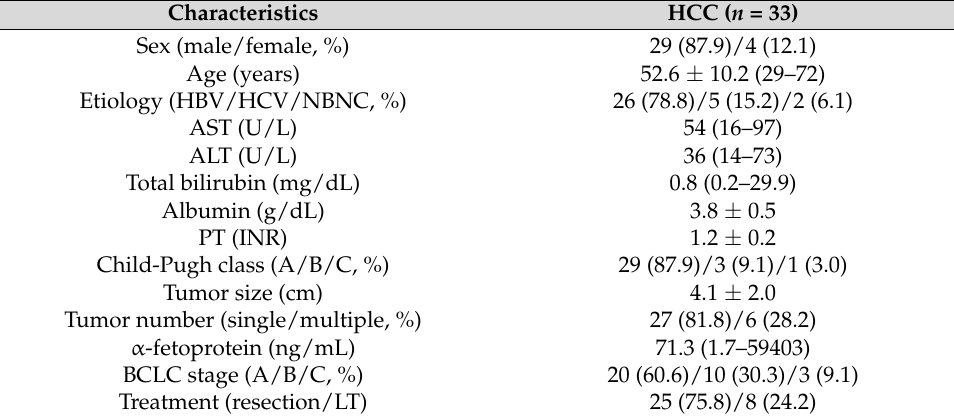
Table 1. Baseline characteristics of the enrolled